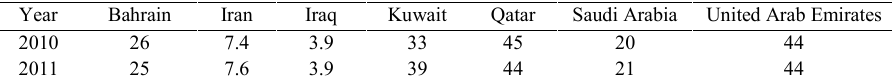
Table 1. Per capita CO 2 emissions from the consumption of energy (Metric tons of CO 2